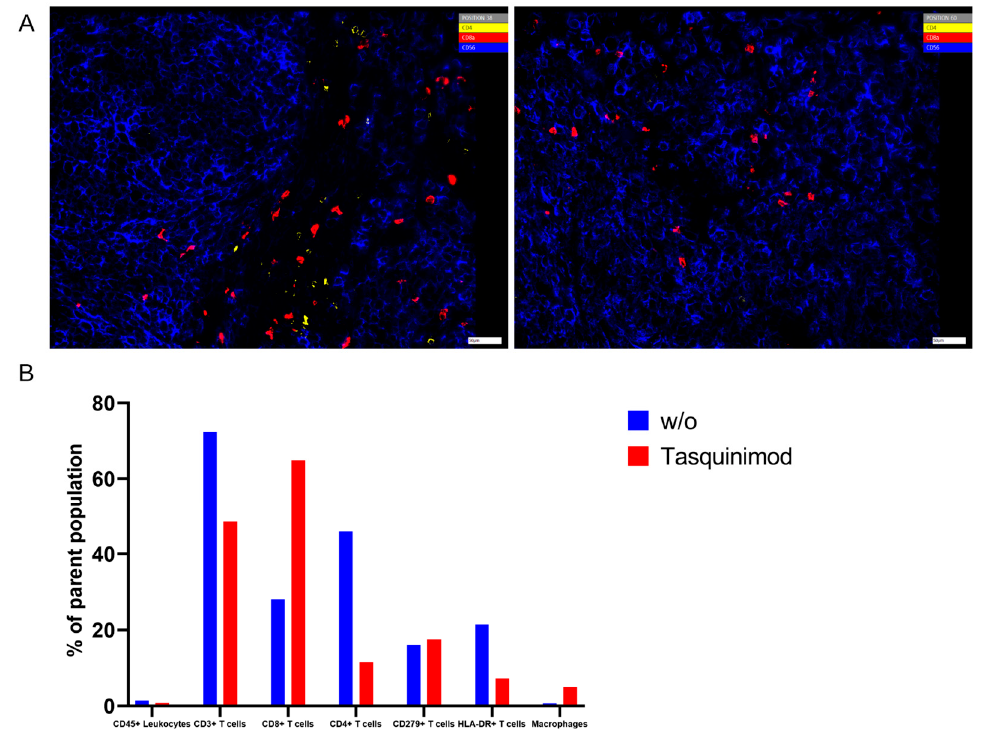
Figure 7. ( A ) Chipcytometry analysis showing exemplarily the identification of tumor-infiltrating CD8 + (red) and CD4 + (yellow) T cells within their spatial context with Tasquinimod ( right ) or without ( left ). ( B ) Percentage of cell populations in a representative section of the TME. One experiment out of two ( w / o ) or out of four (treatment) is shown.